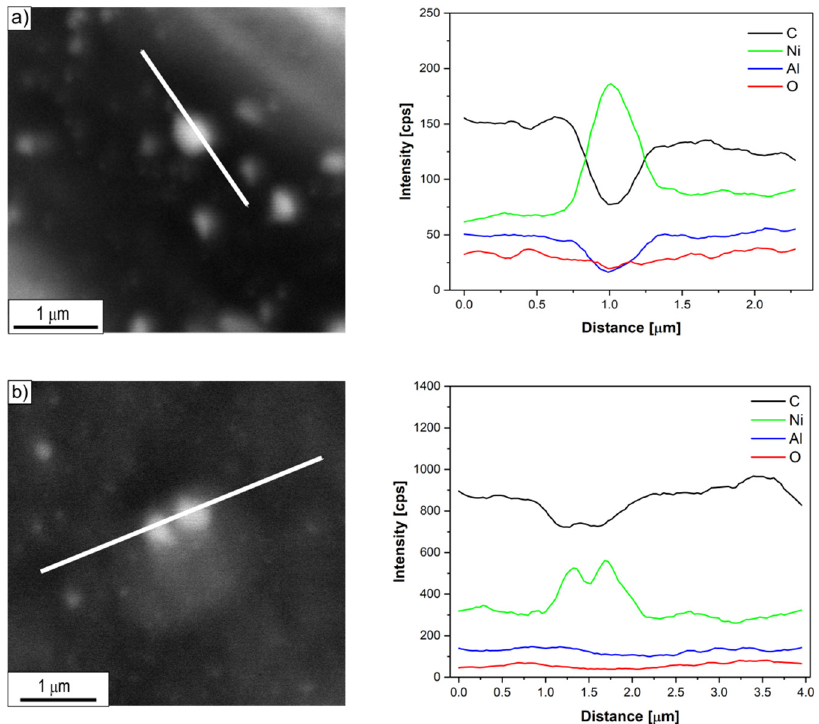
Figure 7. Linear EDS/SEM analysis of the CNT/CNF area with nickel-like nanoparticles formed after decomposition of ethanol with 1.1 vol.% addition of water vapour (mixture #3) at: ( a ) 500 and ( b ) 700 ° C.